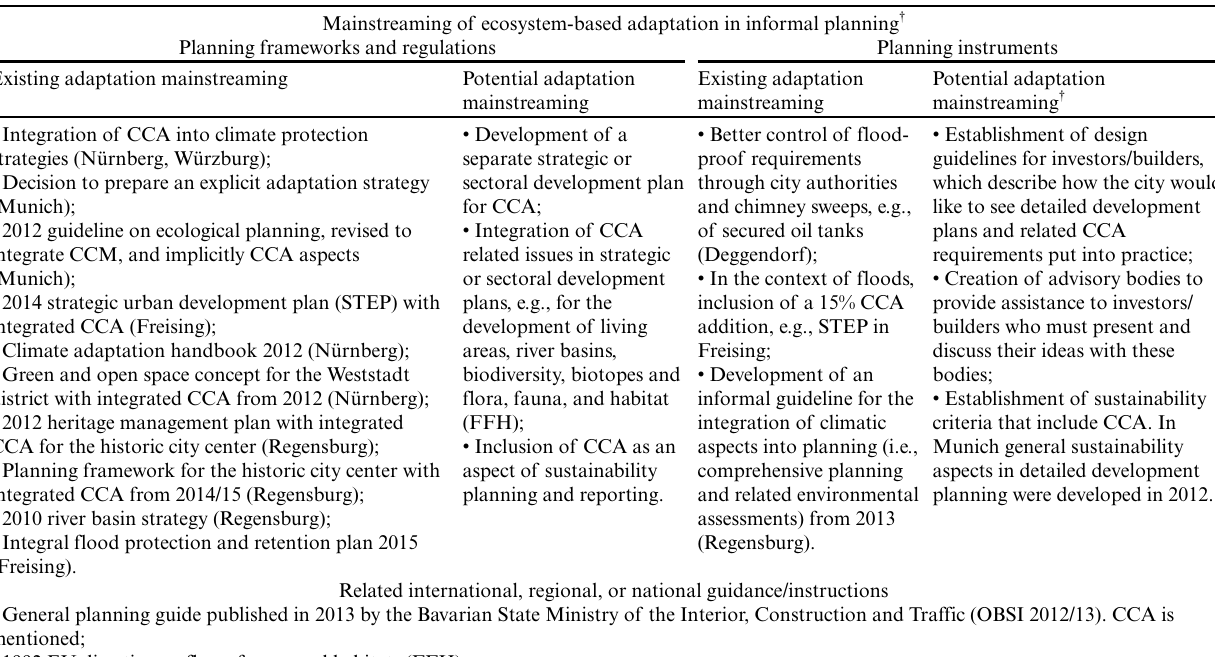
Table 4 . Existing and potential adaptation mainstreaming in informal planning frameworks, policies, and